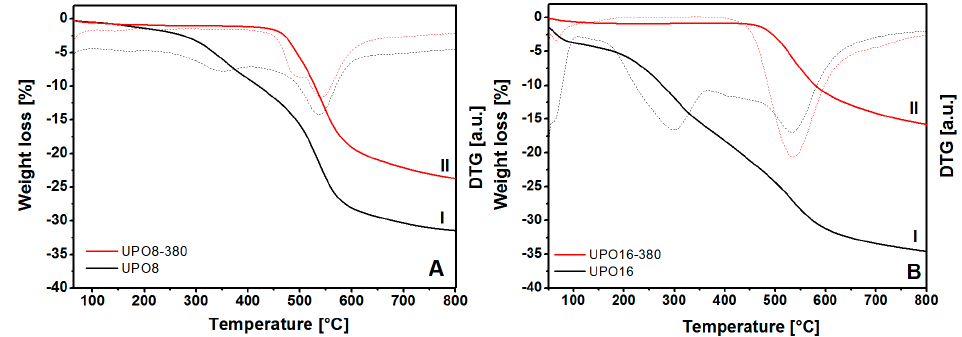
Figure 3. TGA analysis of UPO materials before (I) and after (II) thermal treatment at 380 °C for UPO8 (frame ( A )) and UPO16 (frame ( B )). The DTG derivatives are also reported (dashed curves).